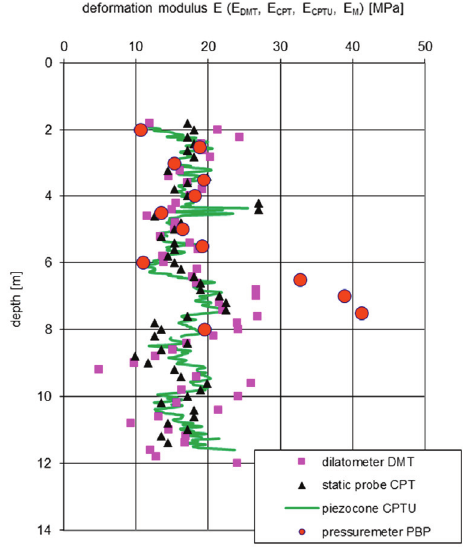
Fig. 4. Deformation modulus in the profile under